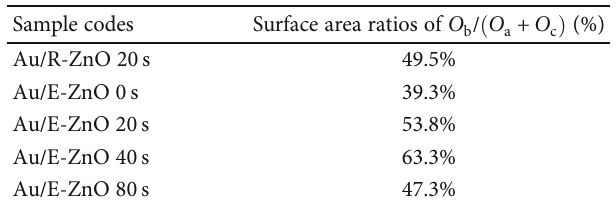
Table 1: The surface area ratios of O di ff erent Au NP deposition